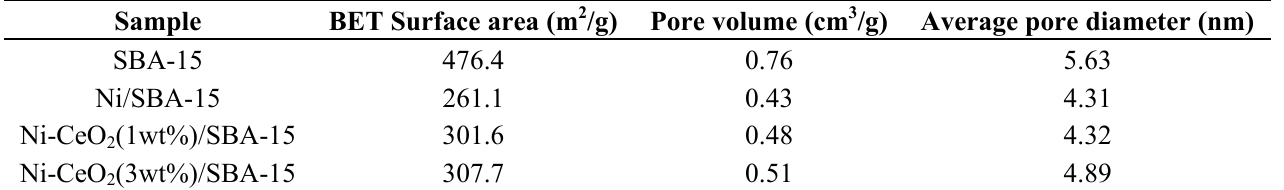
Table 1. Textural properties of the